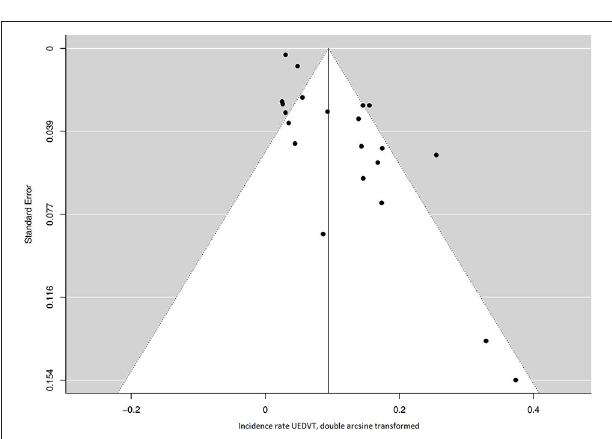
FIGURE 3 | Funnel plot of the included studies for the incidence rate of UEDVT. UEDVT, upper extremity deep vein thrombosis.